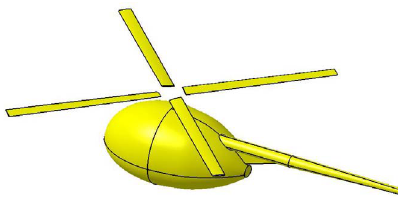
Figure 2. Helicopter model with OH-6 fuselage.